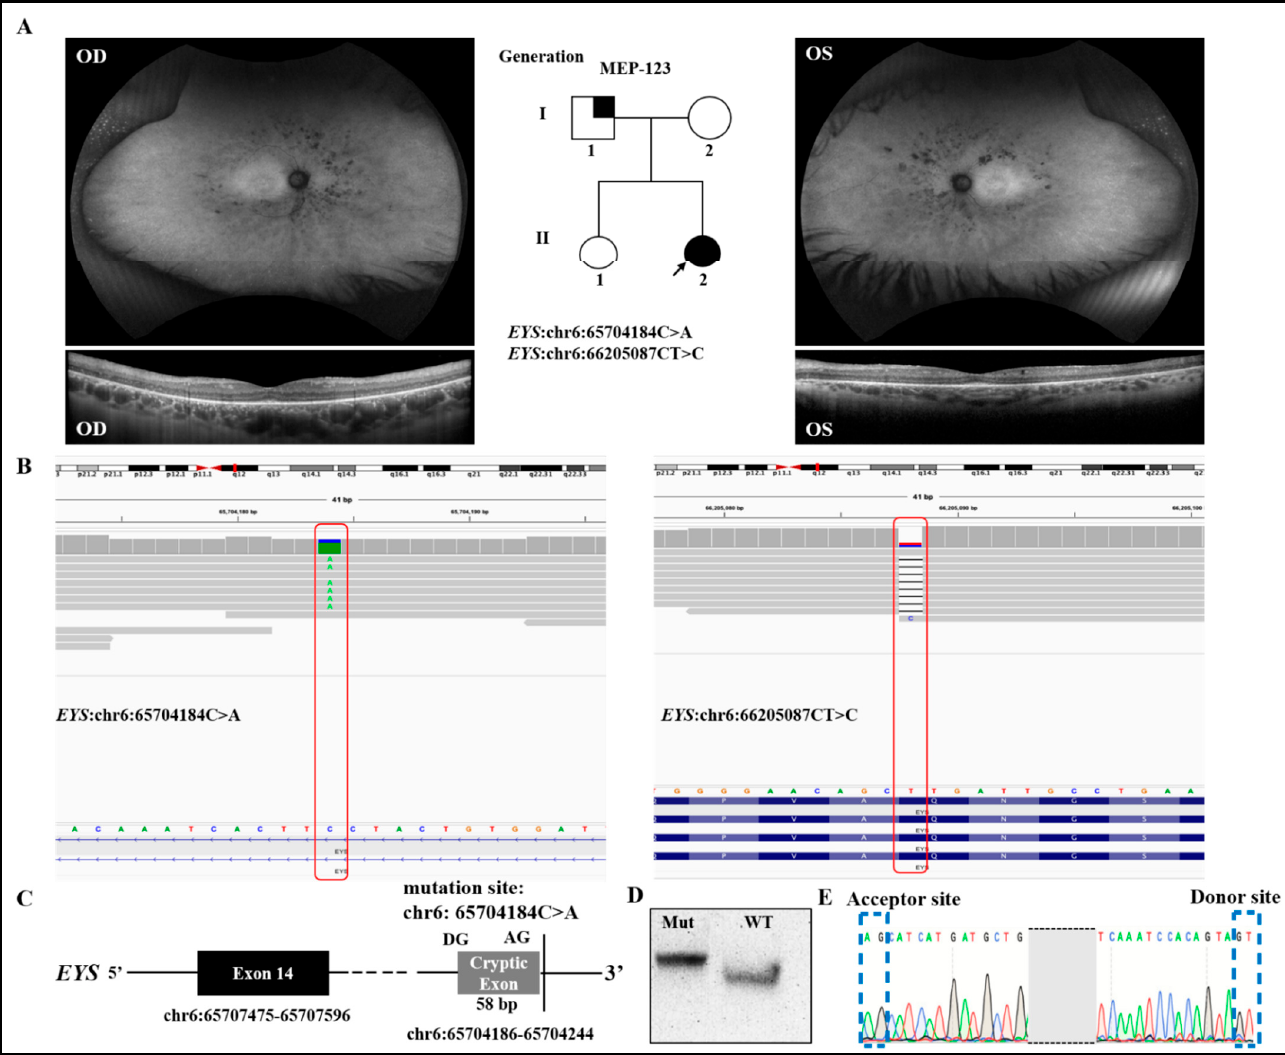
Figure 2. Clinical and functional validation of intronic splicing variant of CHM in MEP-395, who was affected with choroideremia. ( A ) Pedigree of proband, fundus autofluorescence (AF), and optical coherence tomography (OCT) for MEP-395. Symbols represent: females (circles), males (squares), affected individuals (filled symbols), unaffected individuals (open symbols), proband (arrowhead), and slight night blindness (star). ( B ) IGV plot showing the mutant region. A male proband (MEP-395) affected with choroideremia had a pathogenic hemizygous deep intronic variant in CHM (chrX:85237775C>G). ( C ) Predictive results of novel splicing variant identified in proband. ( D ) Gel electrophoresis of reverse-transcription PCR (RT-PCR) of novel splicing variant and WT. ( E ) Confirmation of novel donor and acceptor sites of cryptic exon via Sanger sequencing. Blue dotted lines are showing donor and acceptor